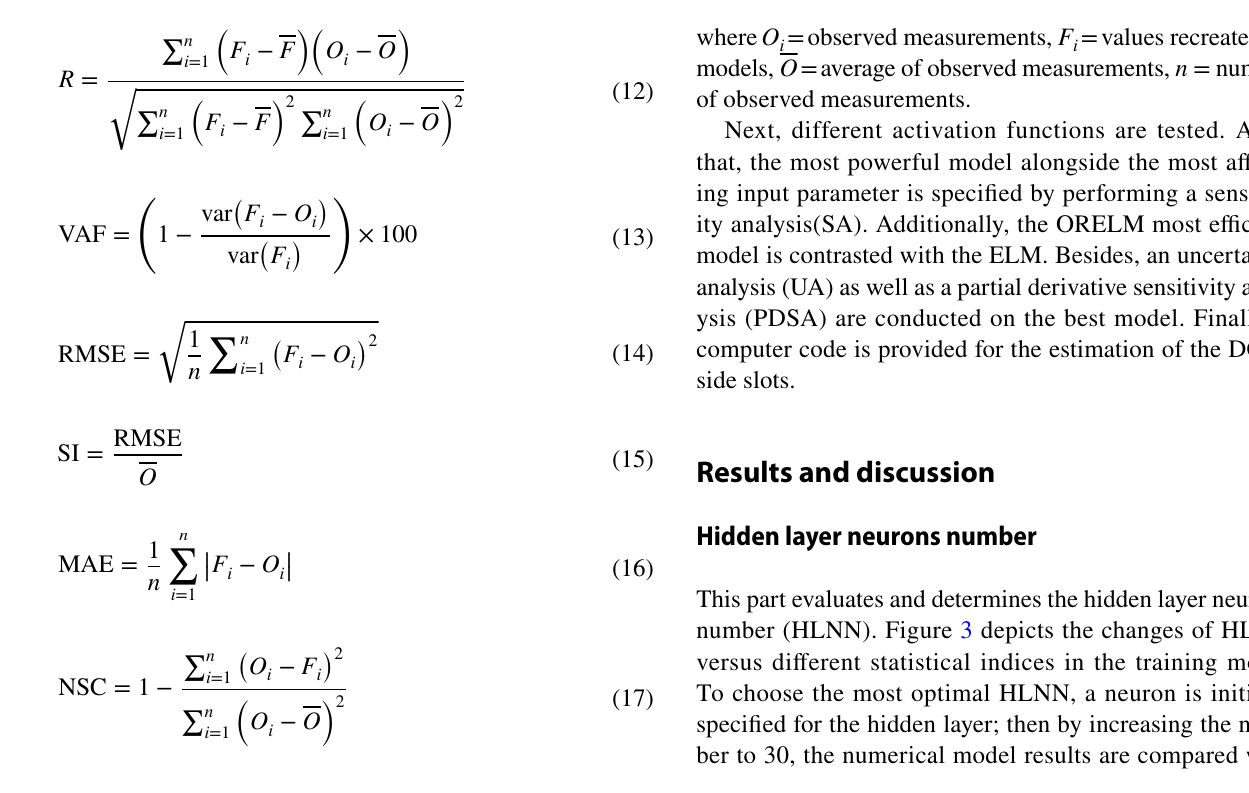
Fig. 7 Comparison of coefficient of discharge simulated by different AFs in both